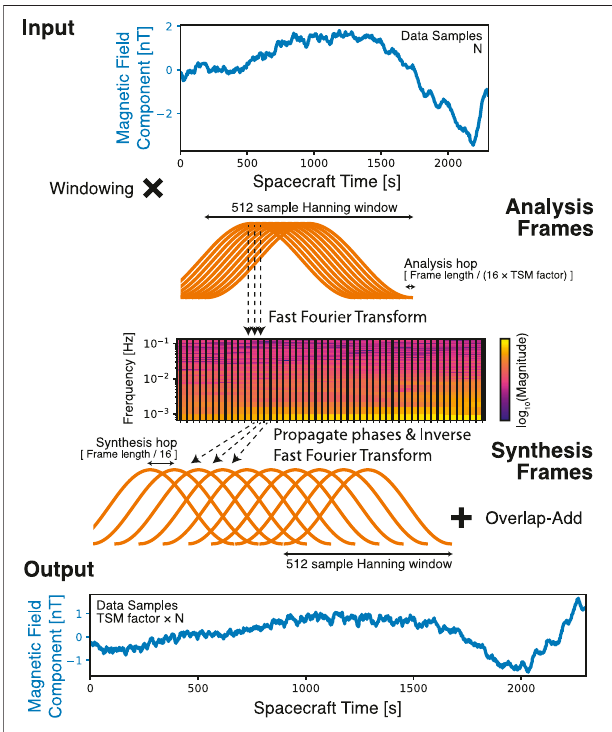
FIGURE 4 | Illustration of the Phase Vocoder method.